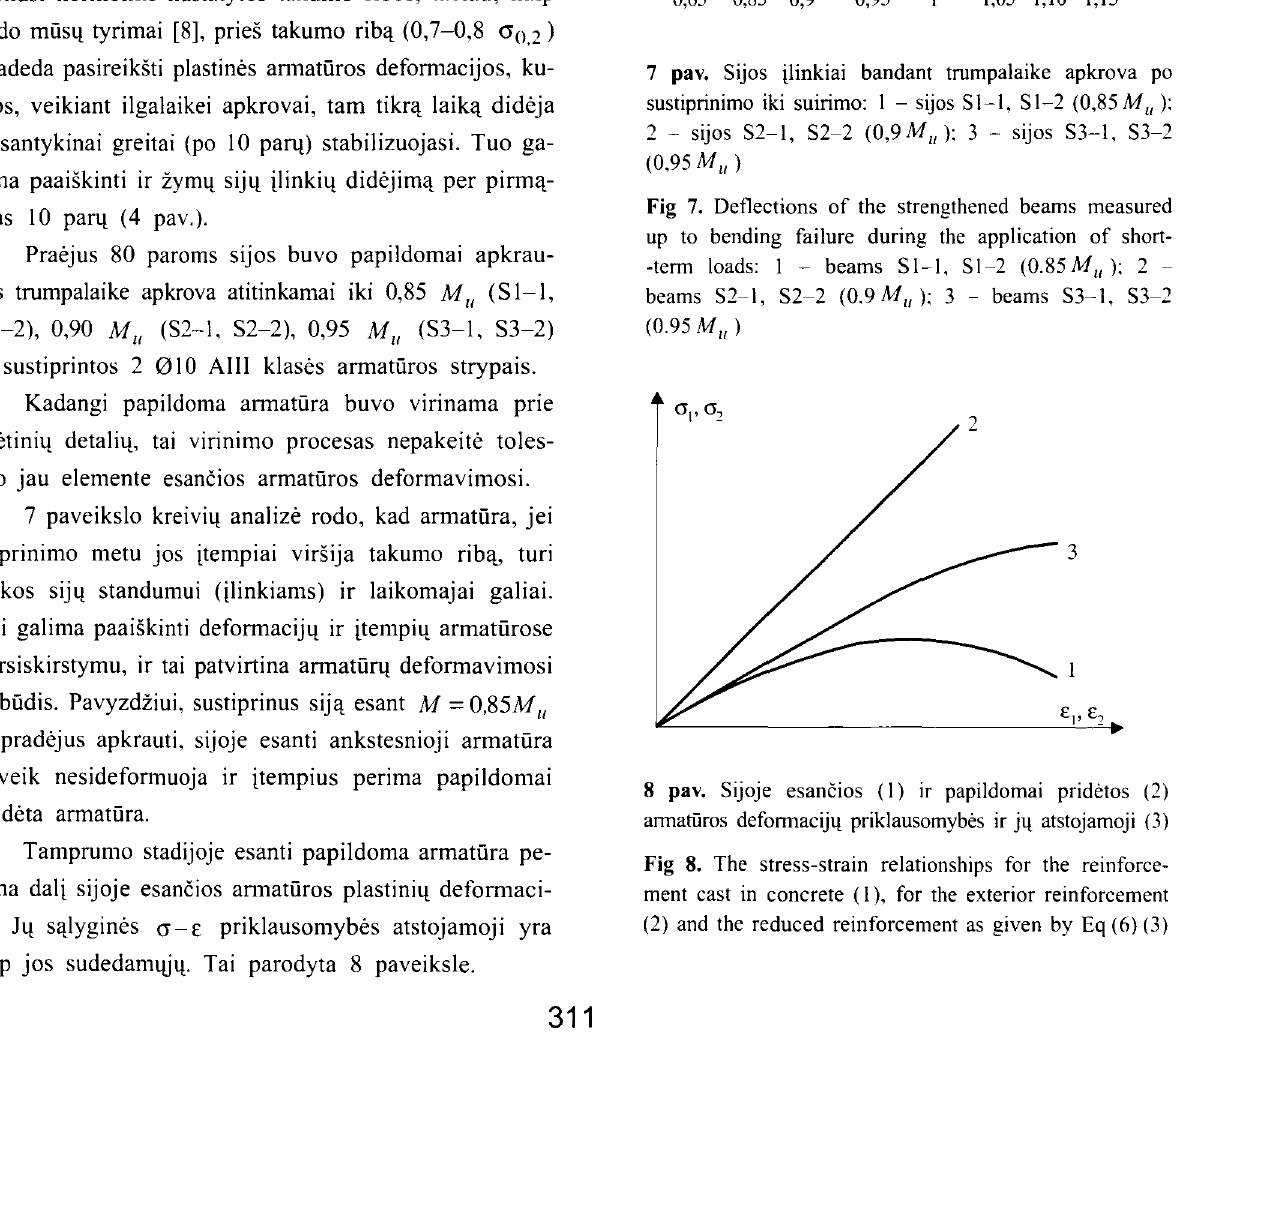
Fig 6. Time-history of the strain in the tensile reinforce ment of the experimental beams exposed to a long-term